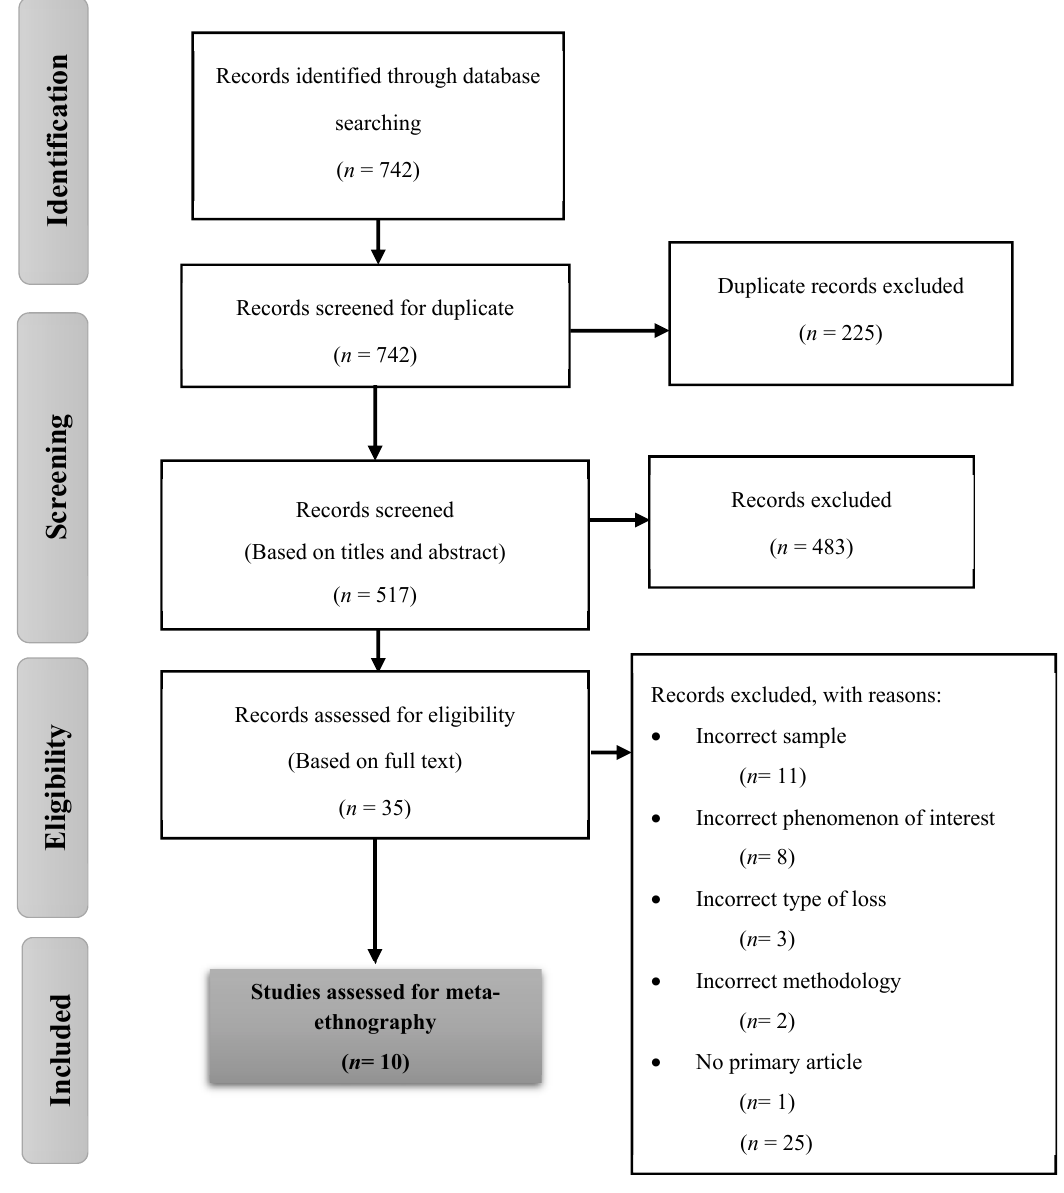
Figure 1. PRISMA flowchart.